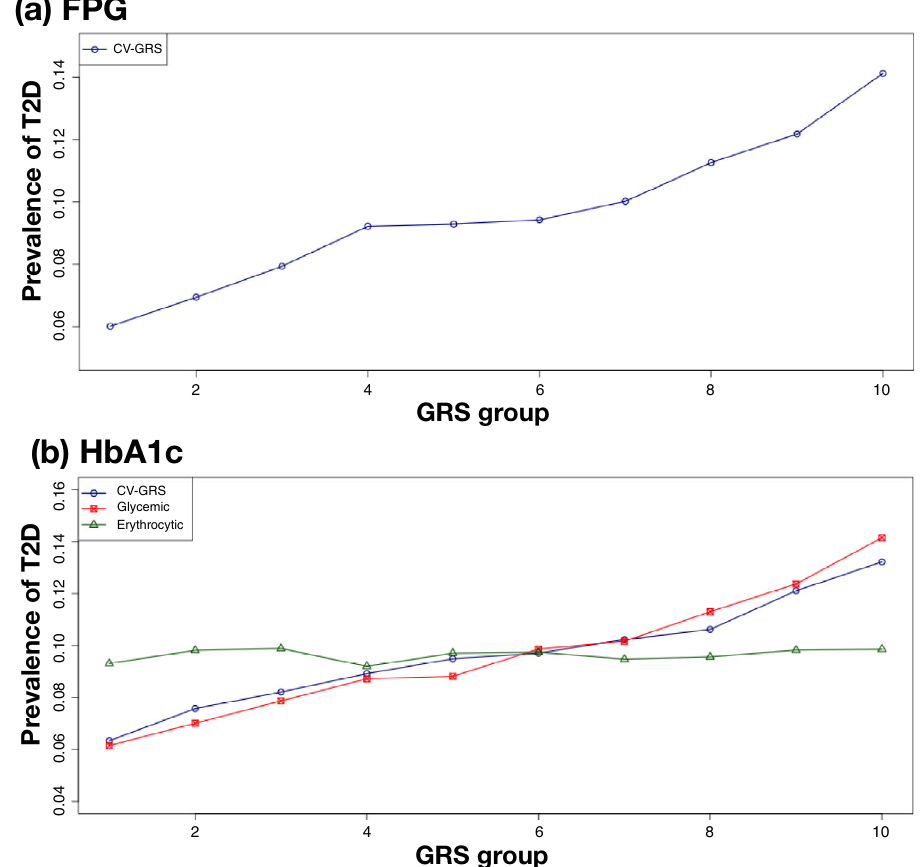
Fig. 3 | Prevalence of type 2 diabetes by GRS group. Samples were grouped into 10groupsbasedonGRSscoresinanincreasing order.CV-GRSindicates GRS using common lead variants identi fi ed in this study. For each GRS bin, T2D prevalence